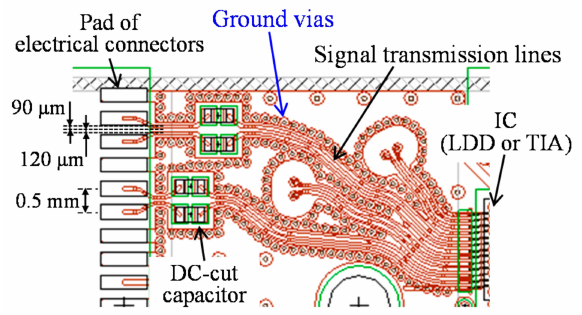
Figure 8. Layout of signal transmission lines and vias.